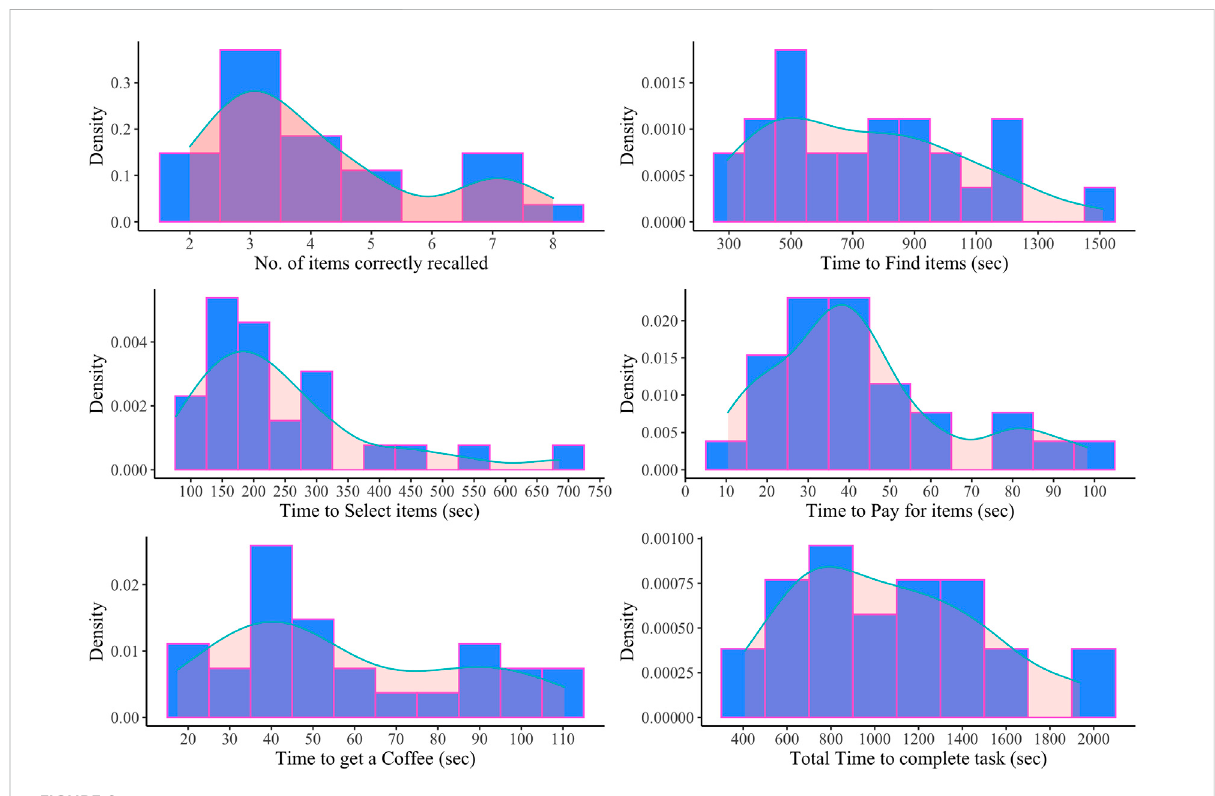
FIGURE 9 Study 3 frequency distributions (in blue) and density plots (in pink) for VStore Recall, Find, Select, Pay, Coffee, and